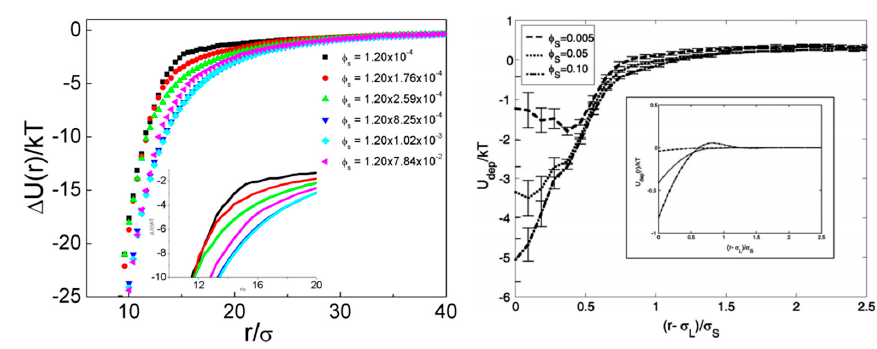
Figure A2. Comparison of effective interaction between large particles in charged (left): attraction range is longer than 20 times that of small particle size ( σ S = 0.21 µm), attraction depth is larger than − 25 k B T . Cui et al.’s uncharged (right) interfacial systems: range of attraction is around 1~1.5 times small particle size, depth of the attraction caused by small particles is up to 5 k B T . Charged system demonstrated a longer range and stronger depth in attraction than in the uncharged system.